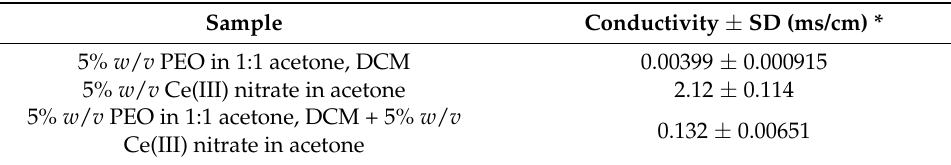
Table 1. Conductivity of PEO/Cerium(III) nitrate solutions.